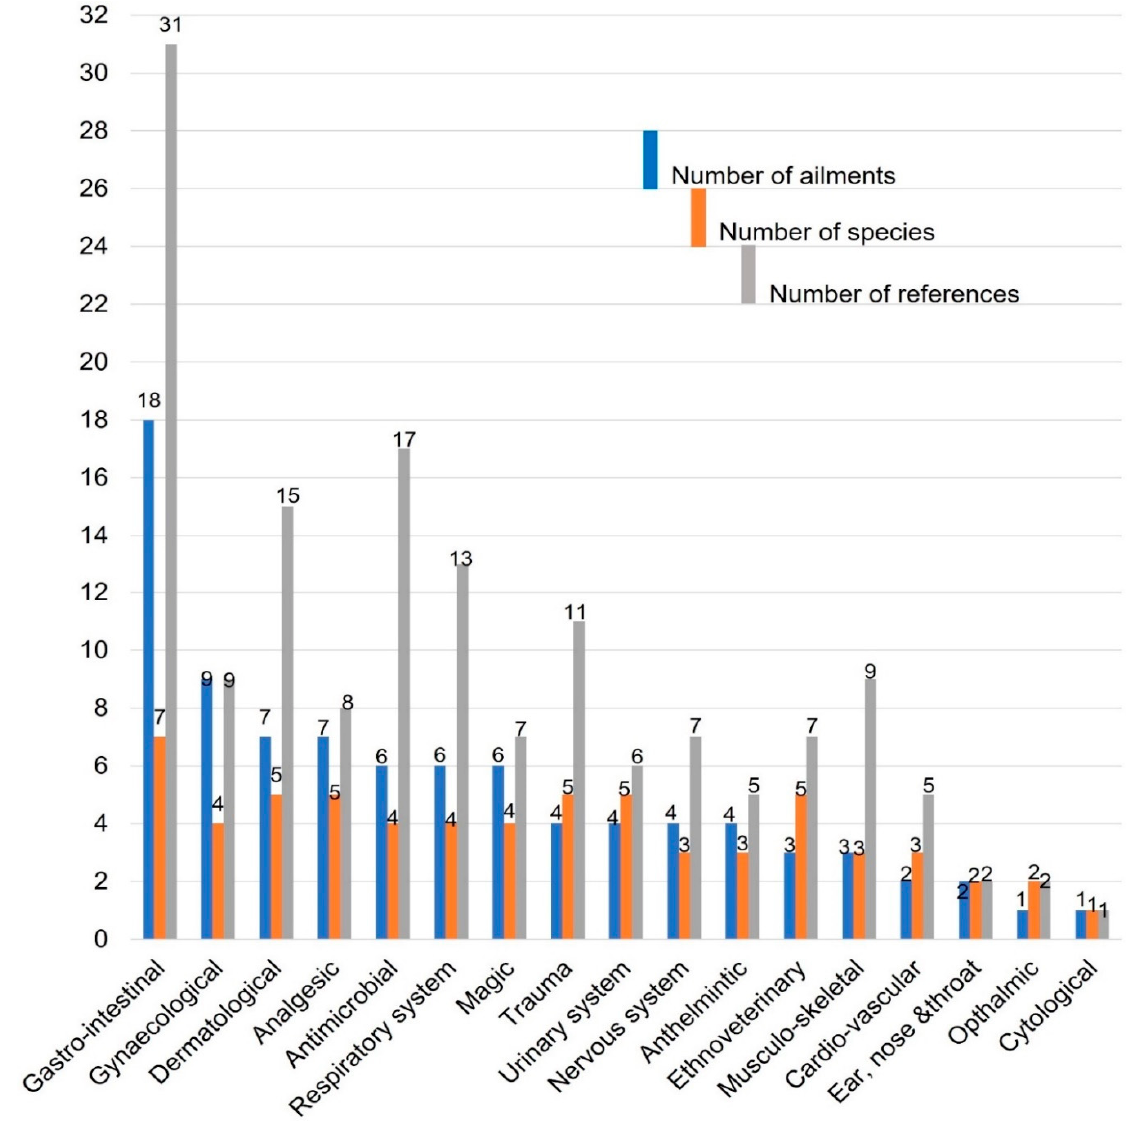
Figure 2. Number of ailments in each category, species used in the treatment of each category of ailment, and references for South African